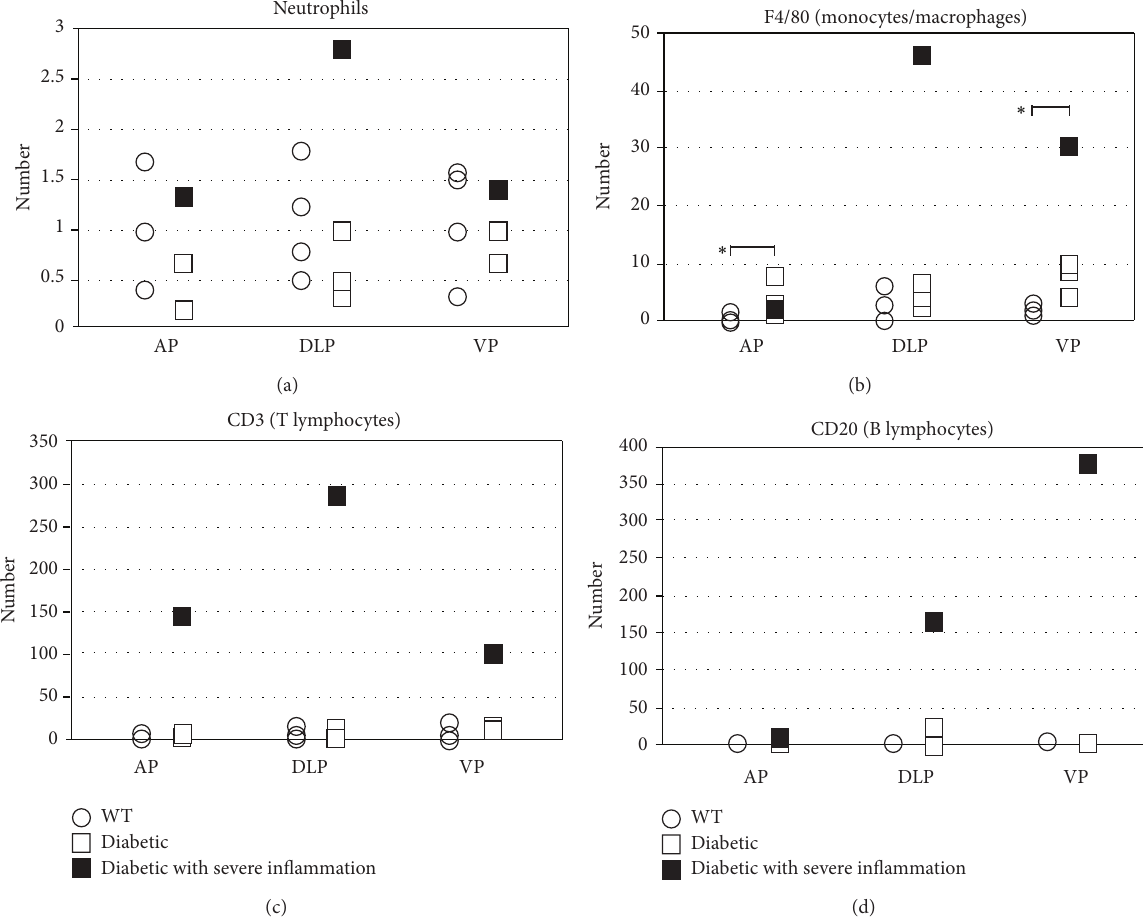
Figure 2: Number of inflammatory cells in the AP, DLP, and VP of 18-week-old DBA2J (WT, white circles), DBA2J.Ins2-Akita (diabetic, white squares), or DBA2J.Ins2-Akita with severe inflammation (diabetic, black squares) by H&E staining and IHC presented as the mean number of cells. (a) Neutrophils, (b) monocytes/macrophages, (c) T lymphocytes, and (d) B lymphocytes. ∗ 𝑃 value < 0.05.